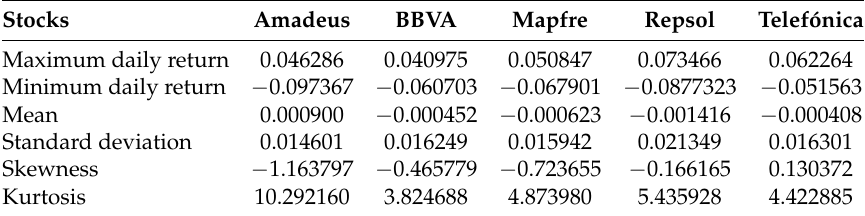
Table 1. Summary statistics. The sample size is m = 261 for all sets.